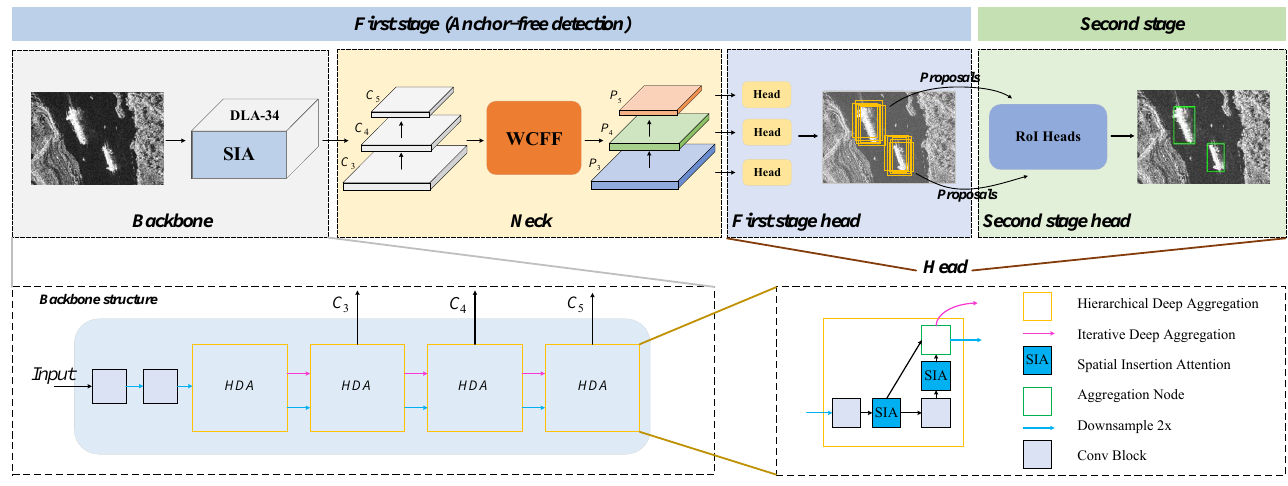
Figure 2. The overall framework of ATSD follows the usual object detector design manner: “Backbone- Neck-Head” . The SIA module embedded in the backbone network and the WCFF module embedded in the neck block are introduced in the first stage, and the head network spans the first and second